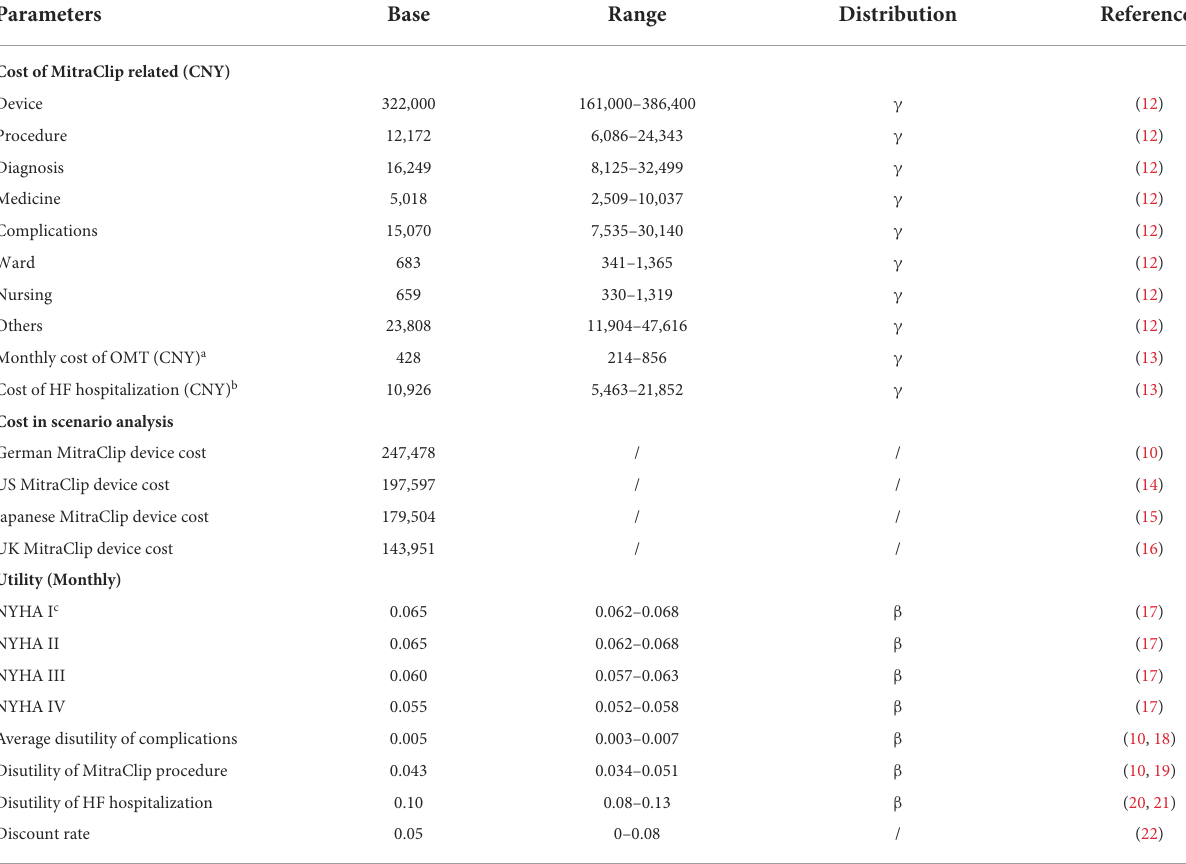
TABLE 2 Input parameters of decision tree and Markov